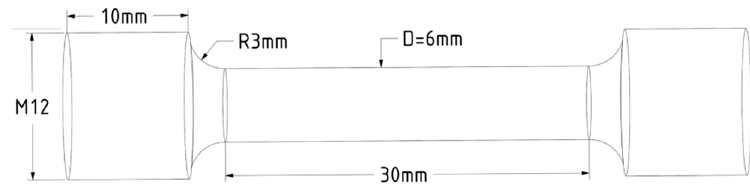
Figure 2. Dimensions of a cylindrical tensile specimen.